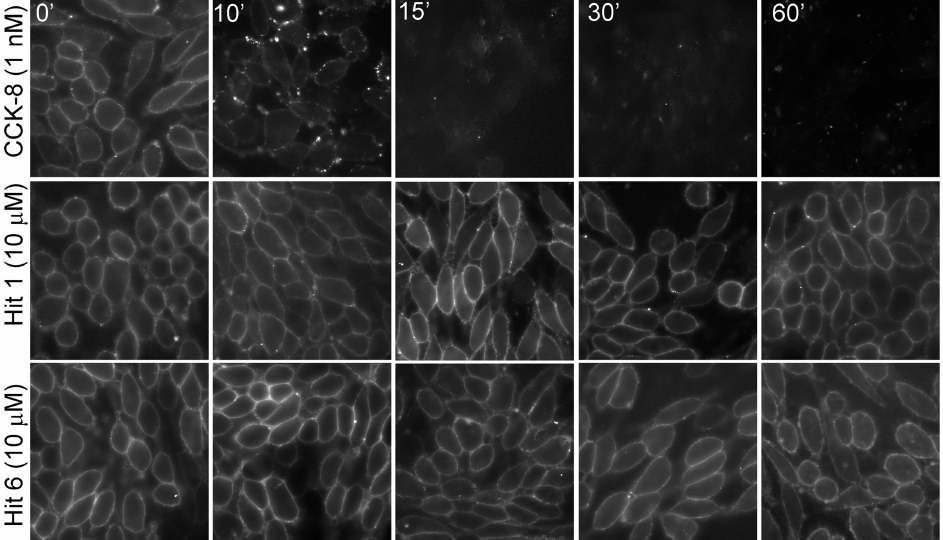
Figure 4. Impact of “hits” 1 and 6 on CCK1R internalization. “Hits” 1 and 6 were utilized in 10 µ M concentrations. Alexa488-CCK was utilized to label the cell surface CCK receptor. Shown are time- dependent fluorescence images of cell surface CCK1R after exposure to CCK and the two “hits”. CCK stimulated prompt receptor internalization, while neither “hit” cleared the receptor from the cell surface. Images shown are representative of data from three independent